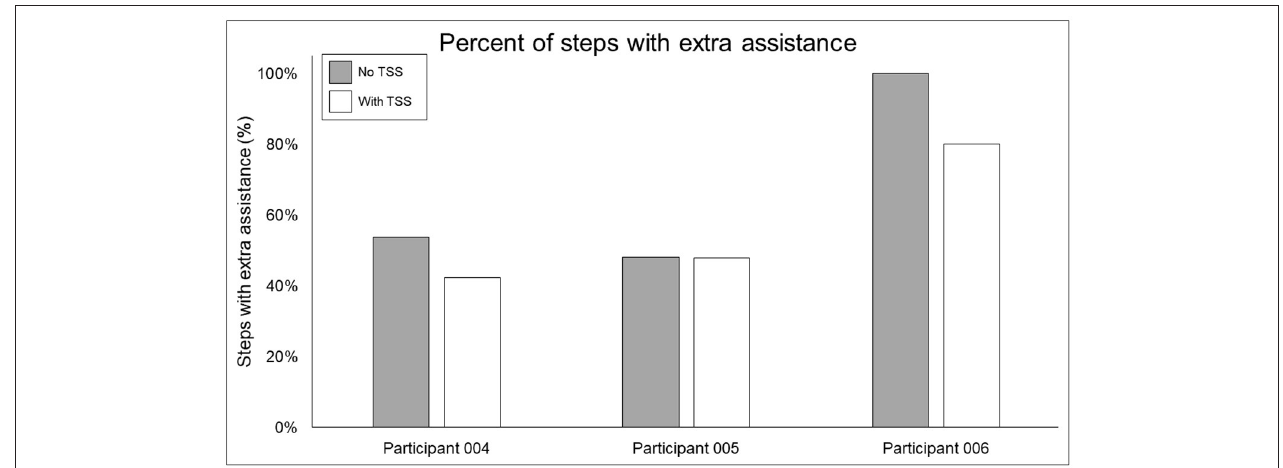
FIGURE 9 | Percentage of steps requiring extra swing assistance from the exoskeleton beyond the minimum percentage achieved through training. Gray bars show the percentage of steps during a 10MWT without (gray bars) vs. with (white bars) trans-spinal stimulation—a lower value indicates that fewer steps in a given bout required extra assistance beyond the programmed level in the exoskeleton. TSS, trans-spinal